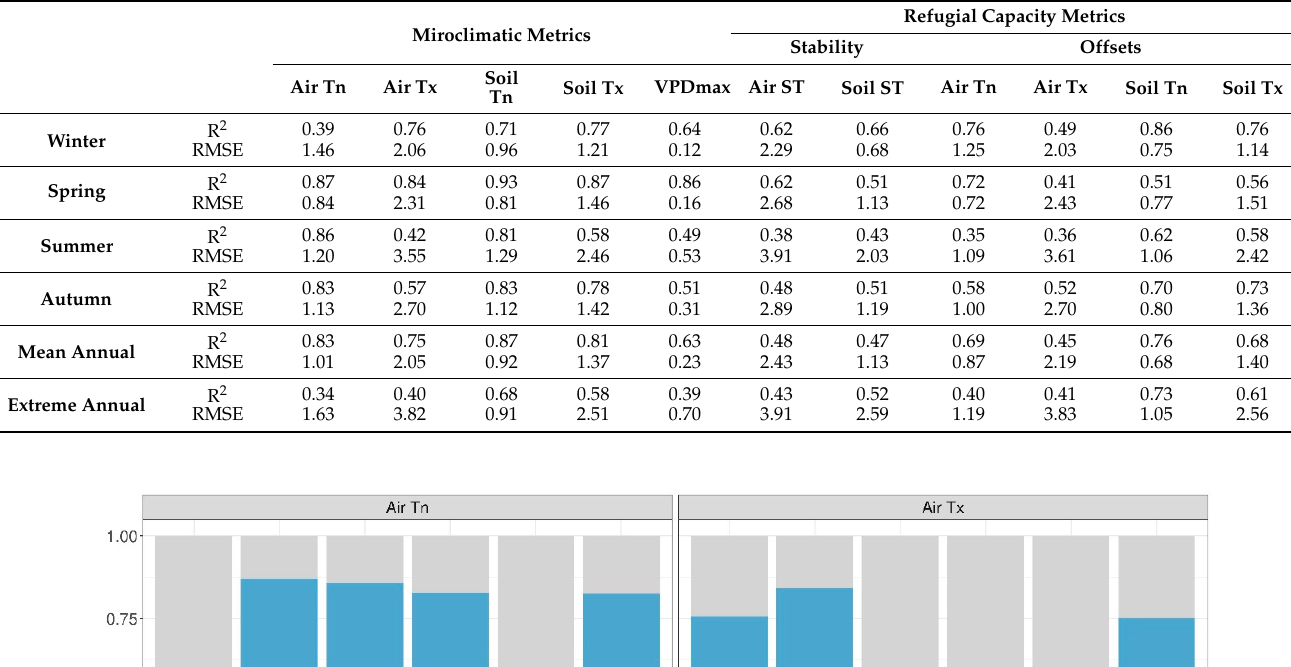
Table 3. GLM model performance of microclimatic and refugial capacity metrics for T and VPD. All models were statistically significant ( p -value < 0.001).